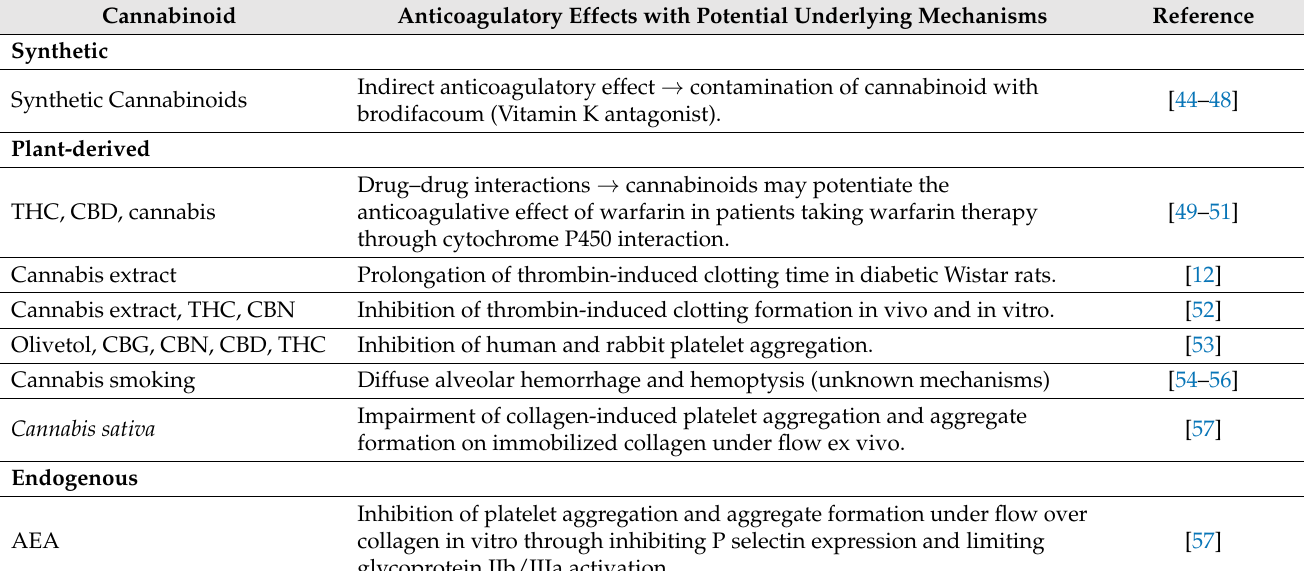
Table 1. Overview of the reported coagulatory effects of various classes of cannabinoids with potential underlying